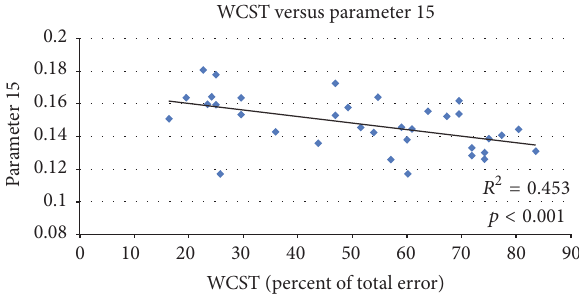
Figure 3: Regression analysis between loading parameters 15 and the percentages of total error on the WCST. 𝑅 square value is 0.453; higher loading parameters correspond to lower WCST score.